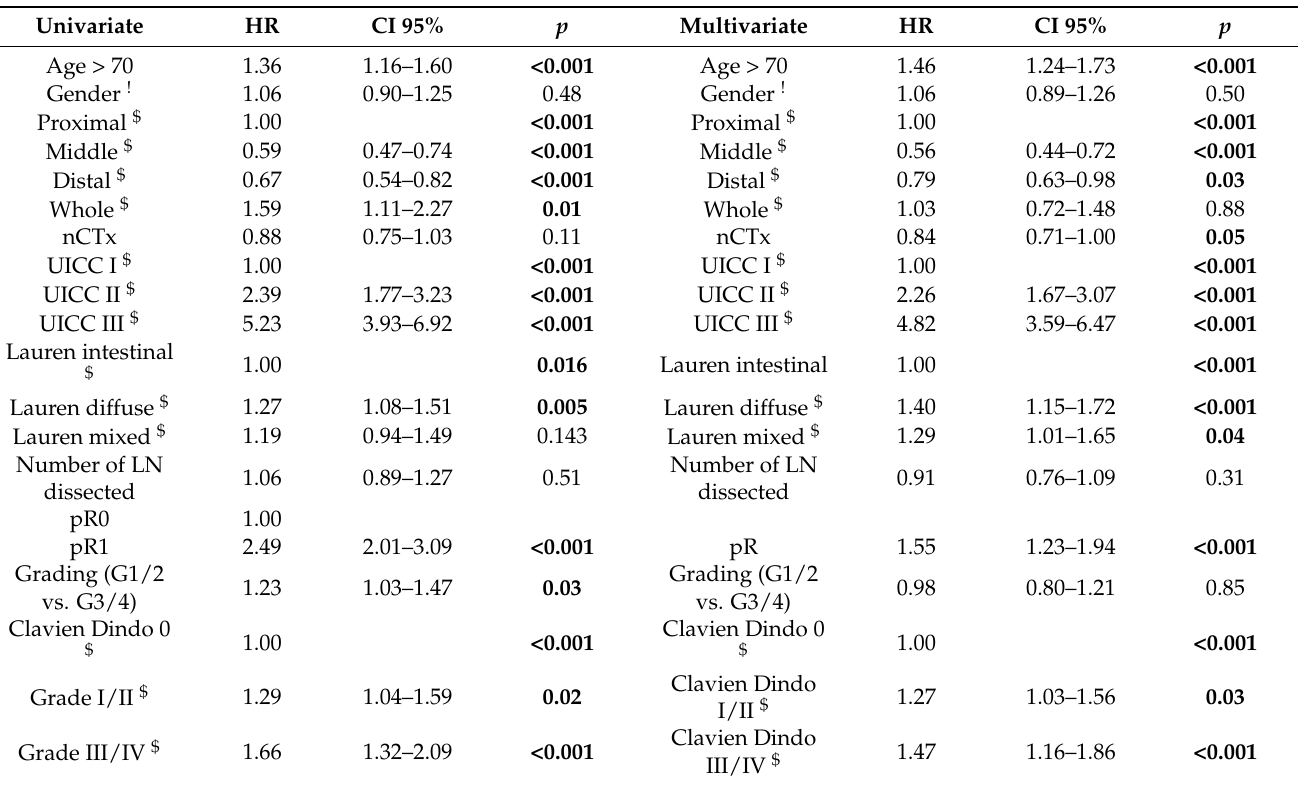
Table 4. Univariate and Multivariate regression analysis for overall survival